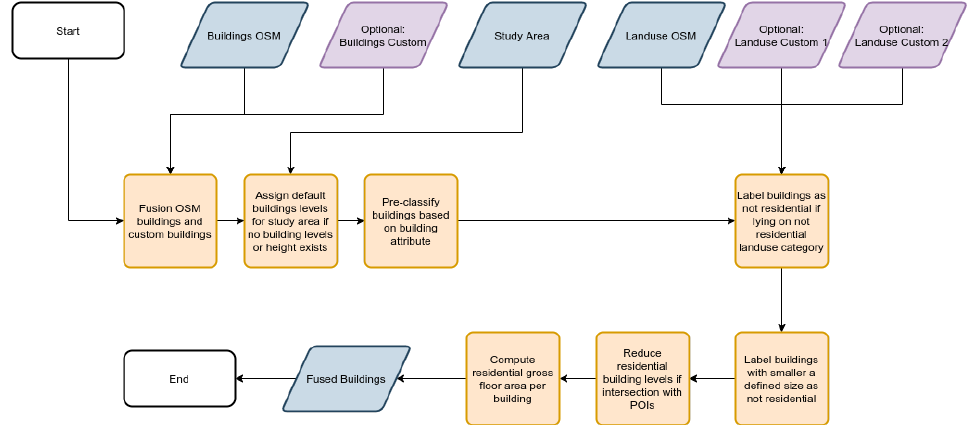
Figure 8. Fusion building data and dasymetric